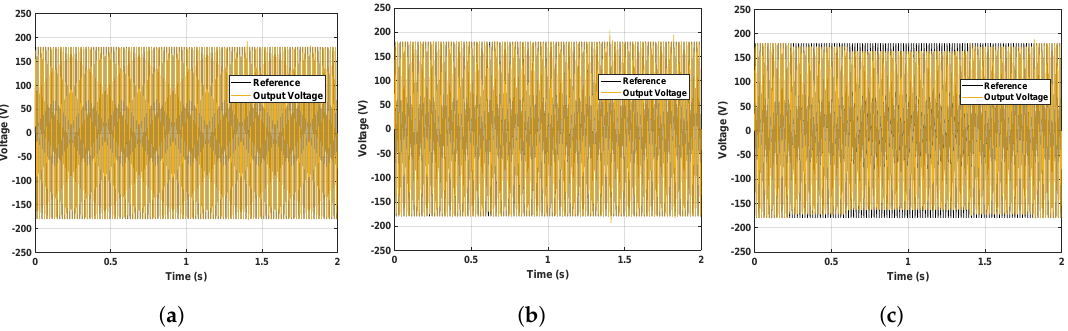
Figure 5. DER output voltage curve different loads. ( a ) 100% linear load with HC. ( b ) 100% non-linear load with HC. ( c ) 100% non-linear load without harmonics compensator (HC).